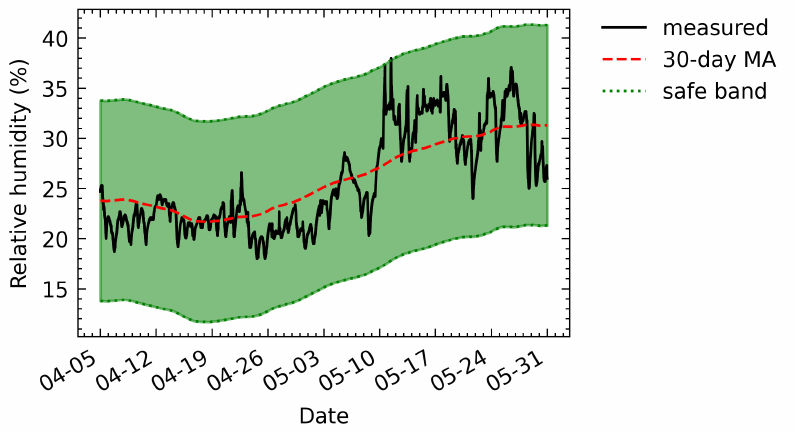
Figure 16. The safe band of relative humidity values for the City